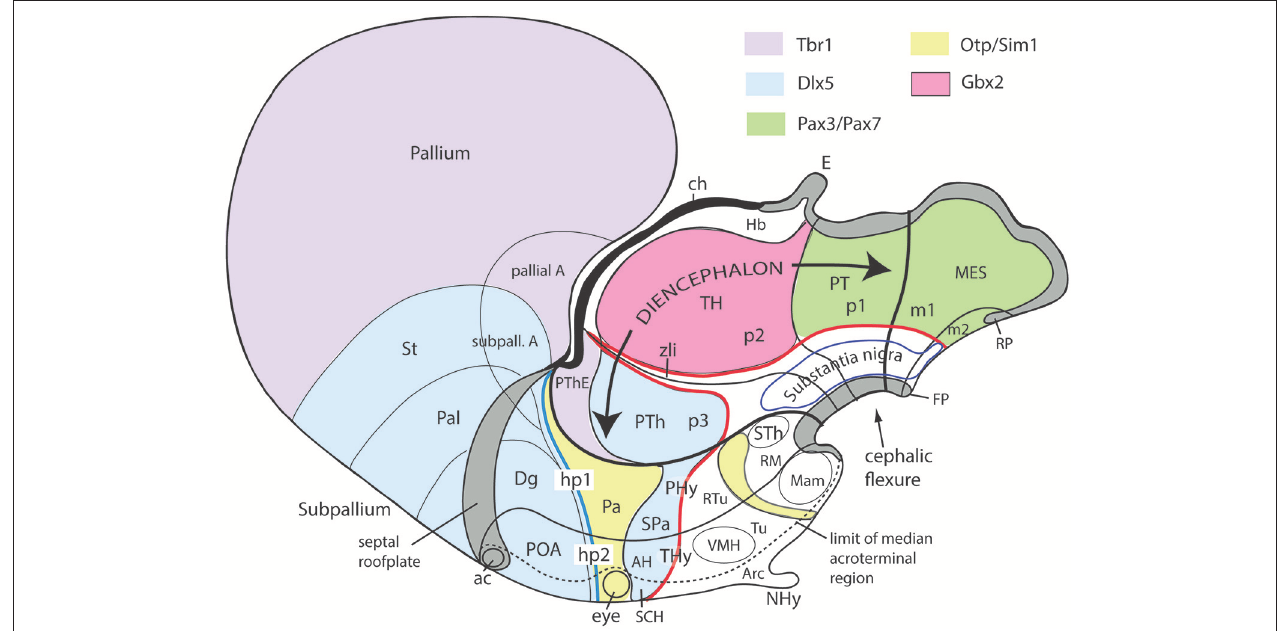
FIGURE 10 | Schematic map copied from Puelles (2015) of various gene expression patterns that agree with prosomeric analysis of the forebrain (largely centered on alar plate domains of the different prosomeres across midbrain, diencephalon and hypothalamus; no copyright permission required); alar-basal limit in red, though the zona limitans transverse spike (zli) is independent from the basal plate, irrespective of its molecular similarity (Shh expression; see Figure 5B ). The mesodiencephalic extent of the dopaminergic substantia nigra and associated ventral tegmental area is mapped, as well as the distinct perimamillary/periretromamillary basal hypothalamic band, in yellow (see text); the separate alar hypothalamic paraventricular area (Pa; also in yellow)shares these particular markers (but not others). Dlx5 is shared among given prethalamic (PTh), hypothalamic (SPa, AH, SCH) and subpallial (St, Pal, Dg, POA) domains typically producing GABAergic neurons. A thick blue line represents the hypothalamo-telencephalic boundary; note telencephalic subpallial inclusion of the POA due to shared gene expression, and local ending of the roof plate at the anterior commissure (ac). Hypothalamic alar and basal subdivisions and some individual nuclei mentioned in the text are